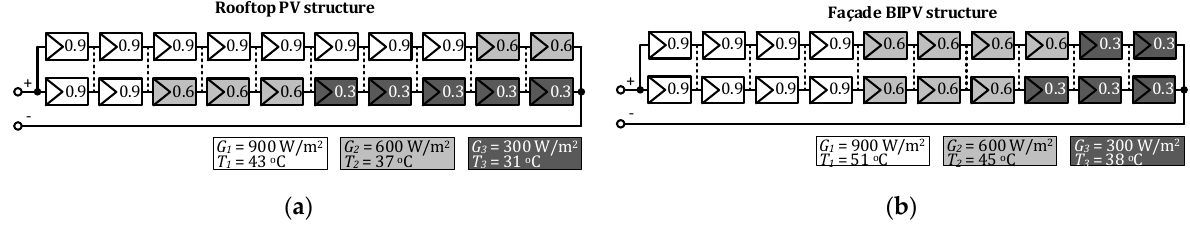
Figure 3. Indicative PS scenarios. ( a ) Long – narrow shading pattern A and ( b ) short – wide shading pattern B.